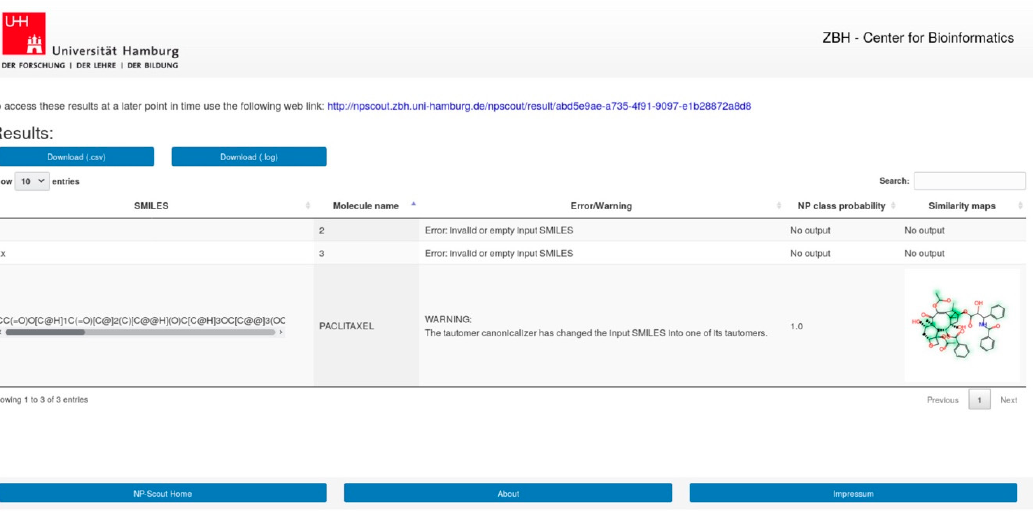
Figure 6. Screenshot of the result page of NP-Scout.